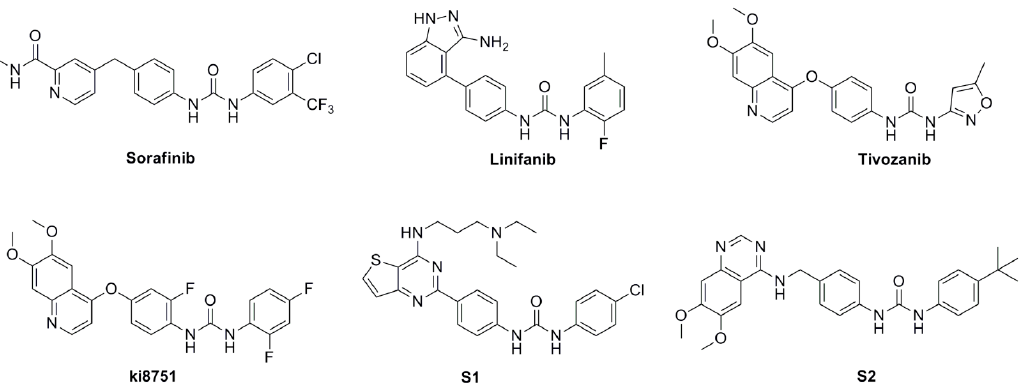
Figure 1. Structures of diaryl urea derivatives.